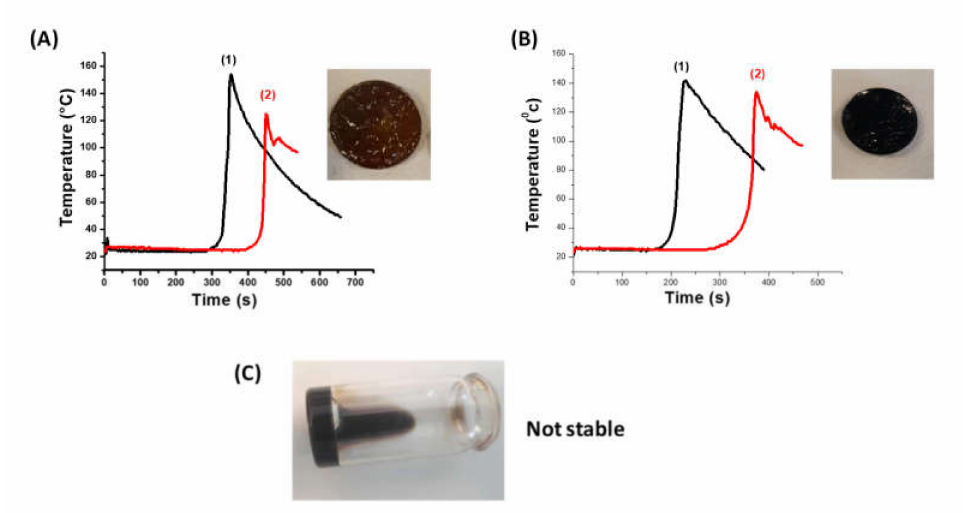
Figure 5. Optical pyrometric measurements (temperature vs. time after mixing, 4 mm thick sample) under air in resin 1 for Redox FRP of ( A ) (1) Mn(acac) 2 / DPS (1 / 1 wt%) fresh formulations and (2) Mn(acac) 2 / DPS (1 / 1 wt%) after 6 days of storage at 50 ◦ C; ( B ) (1) Cu(AAEMA) 2 / DPS (1 / 1 wt%) fresh formulations and (2) Cu(AAEMA) 2 / DPS (1 / 1 wt%) after 6 days of storage at 50 ◦ C; ( C ) Mn(acac) 3 (1 wt%) after 48h of storage in resin 1 at 50 ◦